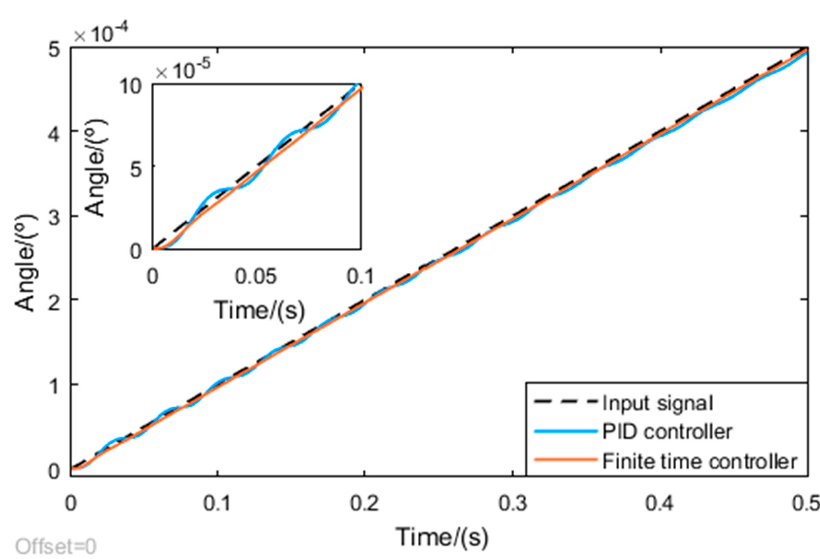
Figure 6. Simulation diagram of finite-time composite control slope signal of the motor system.